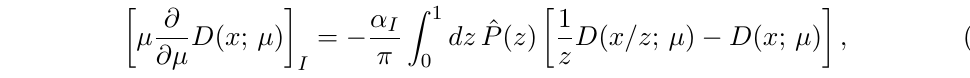
JHEP06(2021)121 , W